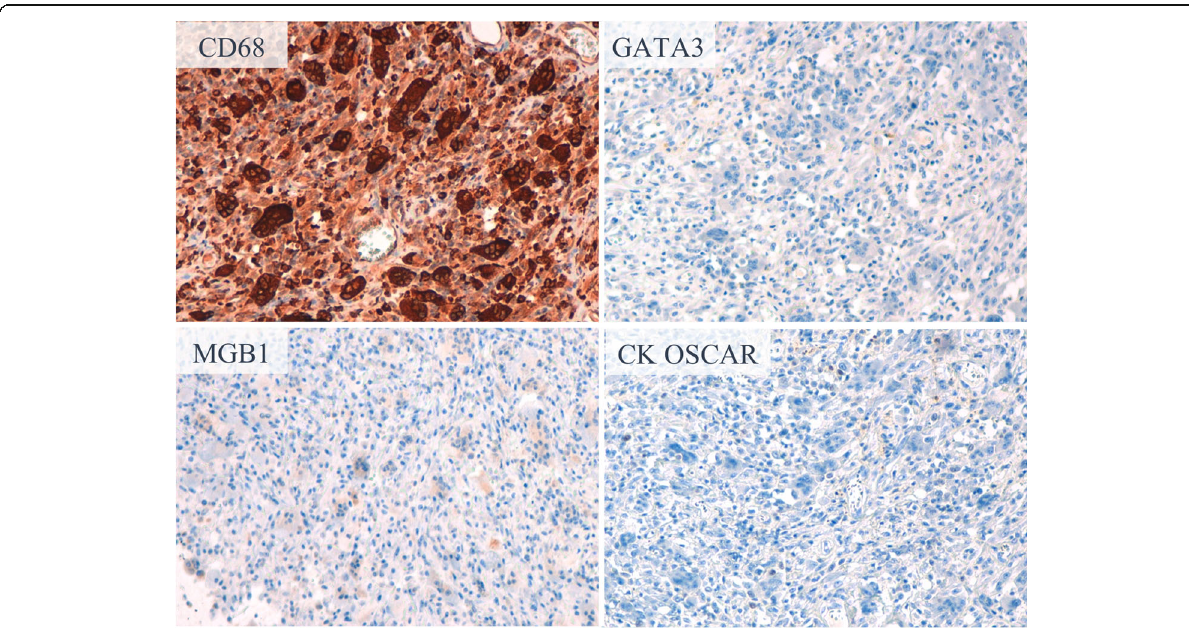
Fig. 4 Immunohistochemistry of the tumor. Oval and spindle mononuclear histiocyte-like cells and multinucleated giant cells stained positively for CD68 and negatively for GATA3, MGB1, and CK